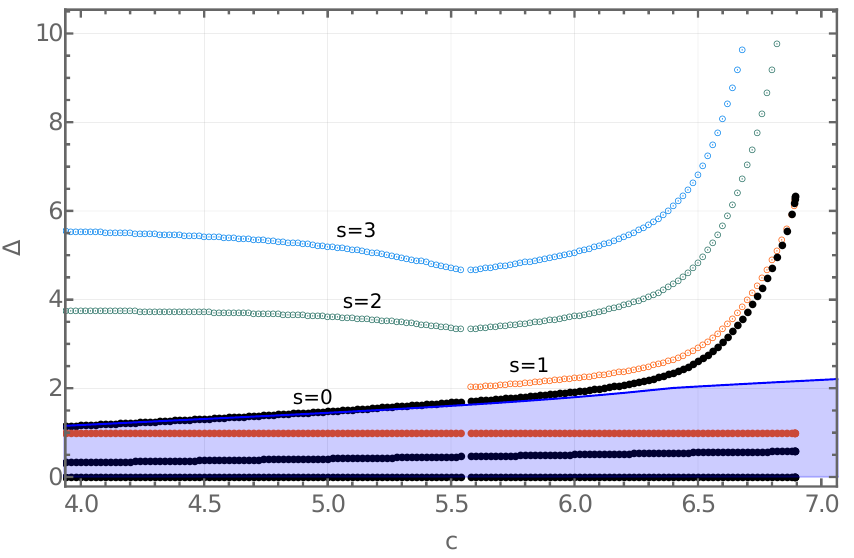
Figure 3 . Roots of the extremal functional evaluated at increasing values of the central charge after the addition of a double root at spin 1. Single roots are denoted by filled circles and double roots are denoted by dotted circles. The blue line shows the extremal gap obtained by semi-definite programming.